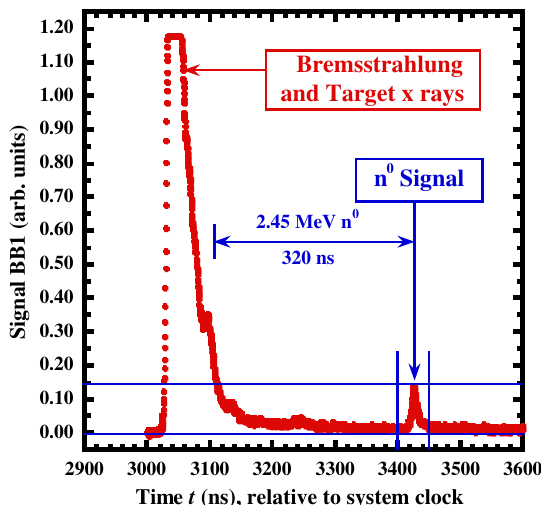
FIG. 3. Raw data from shot 2584 for channel BB1 with an early, off-scale bremsstrahlung signal and extended tail, together with a small nTOF